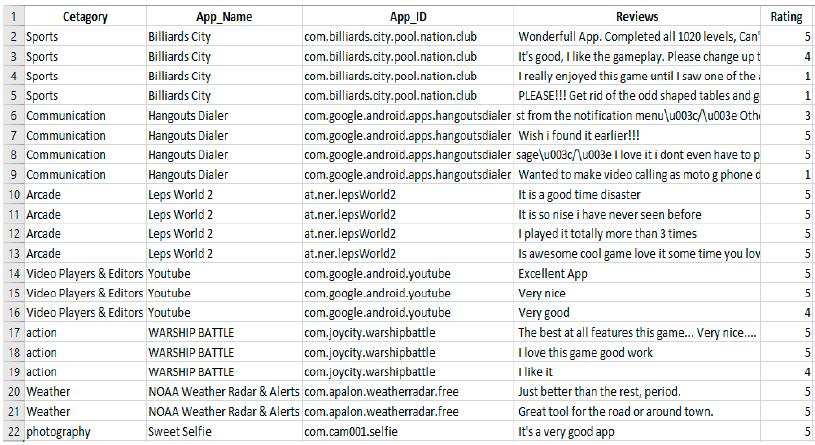
Figure 13. Sample screenshot of the original dataset that was scraped.